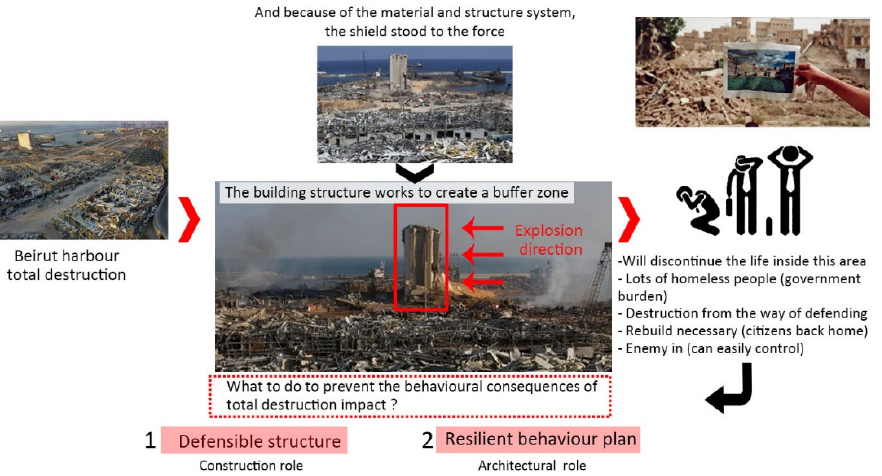
Figure 3. Diagram showing the possible psychological effect of the images of the Beirut harbor explosion. Source: (Y.M.).